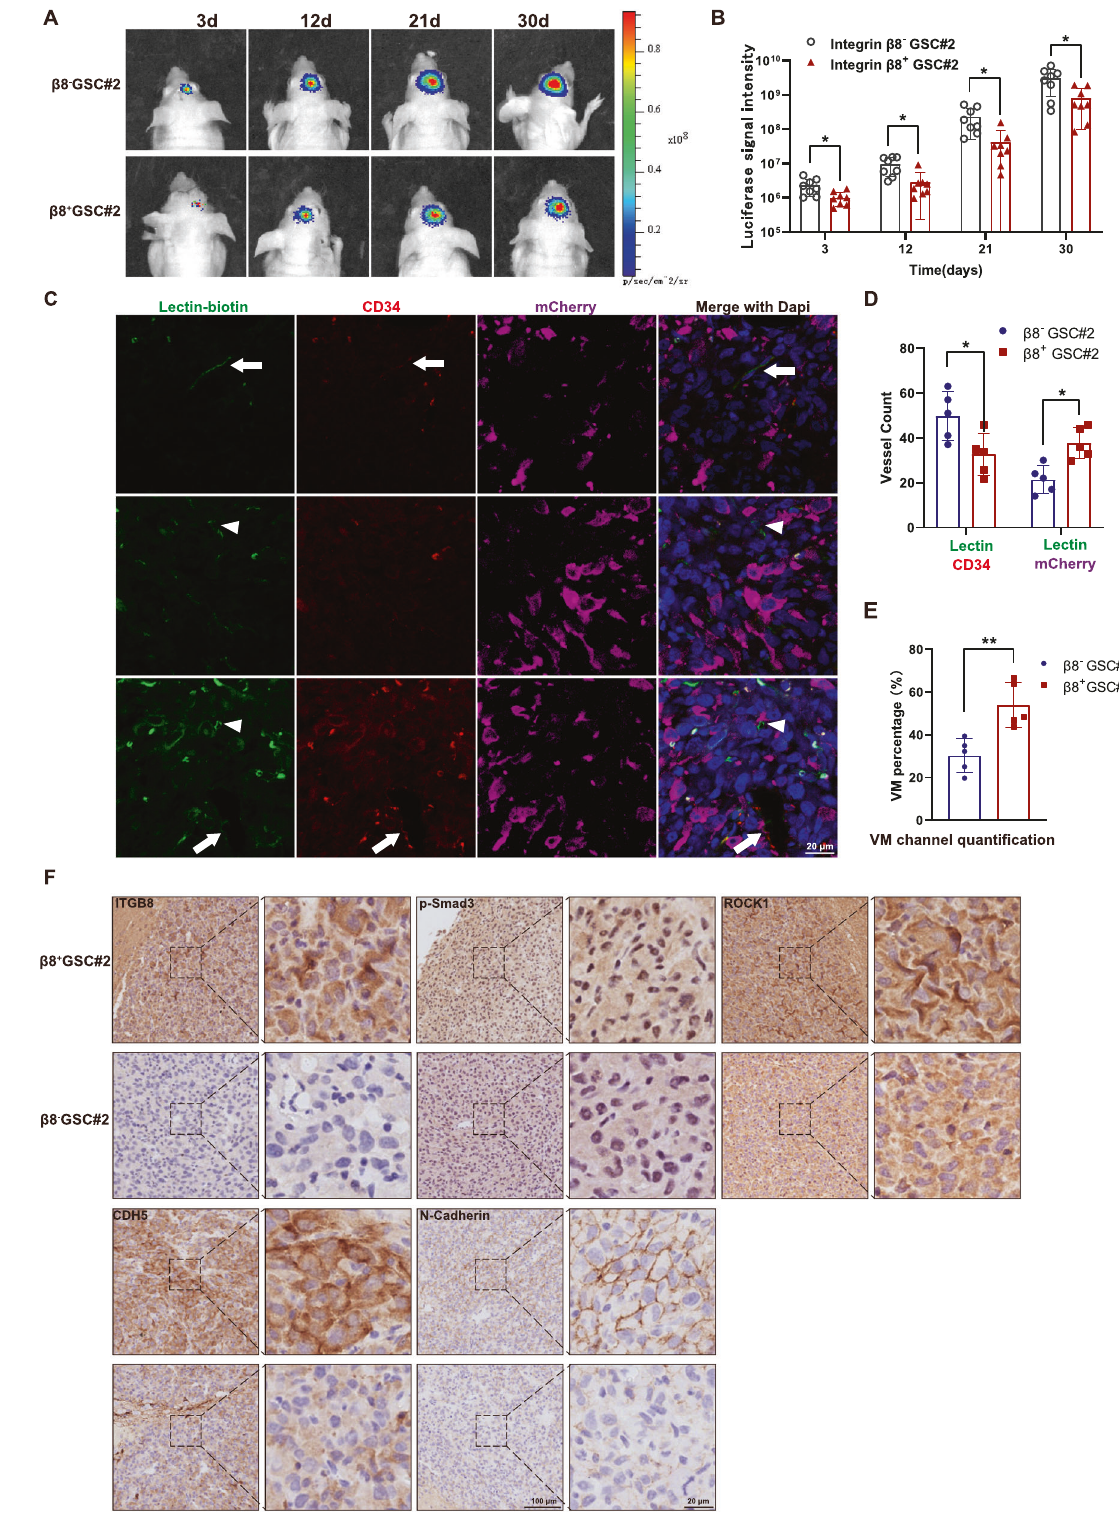
Fig. 6 β 8 integrin contributes to VM formation in intracranial GBM xenograft. A Luminescent imaging of representative nude mice xenografts from mCherry-labeled β 8 + ( n = 8) or β 8 − GSC#2 ( n = 8) at day 3, 12, 21 and 30. B Luminescent signal intensity of GBM-bearing mice in two groups were evaluated. C Representative immuno fl uorescence images of vascular channels lined by ECs or tumor cells. Arrows indicate the regular CD34 + vessels, while arrowheads indicate CD34 - /Lectin + vessels. Scale bar = 20 μ m. D Quanti fi cation of lectin ( + ) vessels stained positively by CD34 or mCherry. E Percentage of VM vessels in β 8 + or β 8 − integrin xenografts. F IHC staining of ITGB8, p-Smad3, ROCK1, CDH5 and N-Cadherin in β 8 + and β 8 − integrin xenografts. Results are represented as mean ± SD of biologically triplicate assays. * p < 0.05, ** p < 0.01, *** p <